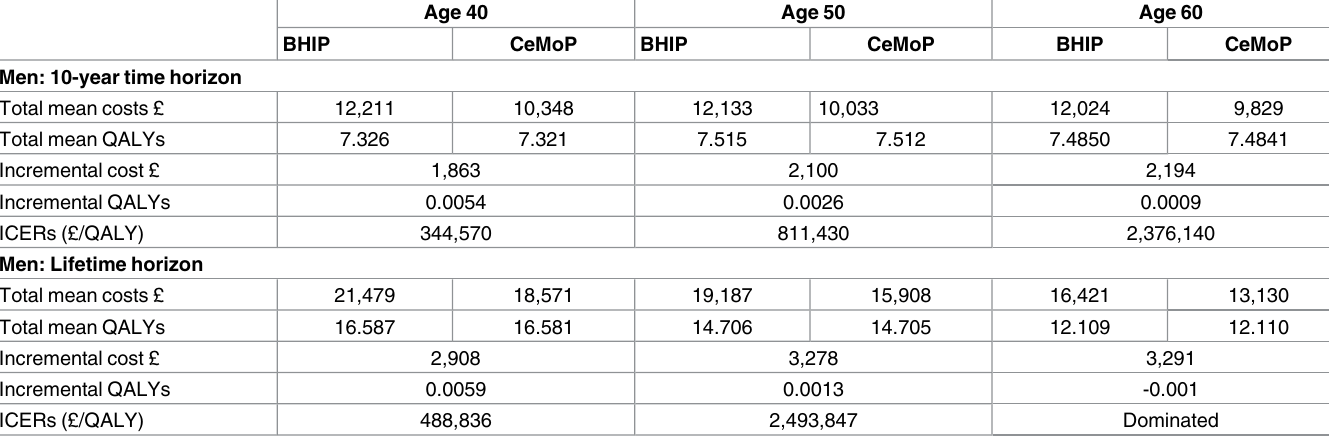
Table 2. Cost-effectiveness results for base case analysis Birmingham hip) versus CeMoP comparison for ASA1 plus ASA 2 male patients aged 40, 50 and 60 years. Age 40 Age 50 Age 60 BHIP CeMoP BHIP CeMoP BHIP